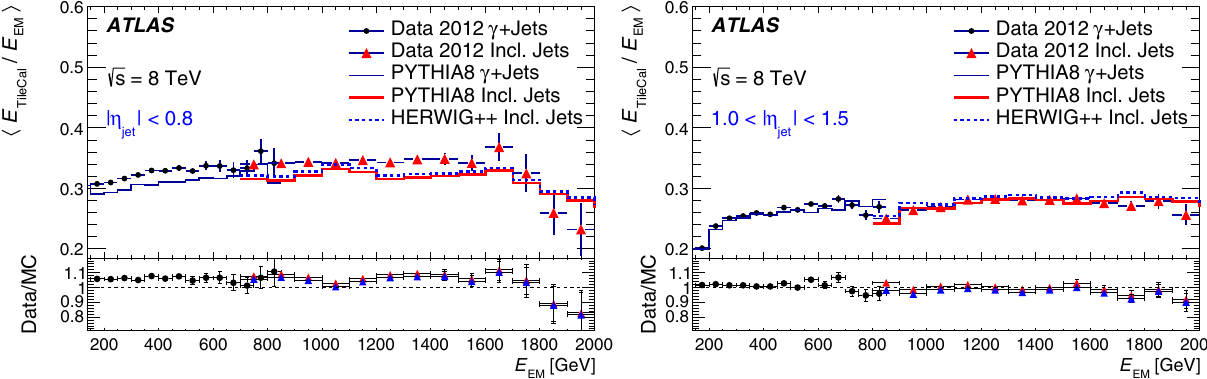
Fig. 27 Electromagnetic scale jet energy fraction in the TileCal for jets after combining the photon-plus-jet and inclusive jet samples for the long barrel (left) and extended barrel (right). Error bars represent statistical uncertainties. The simulation of the inclusive jets done with